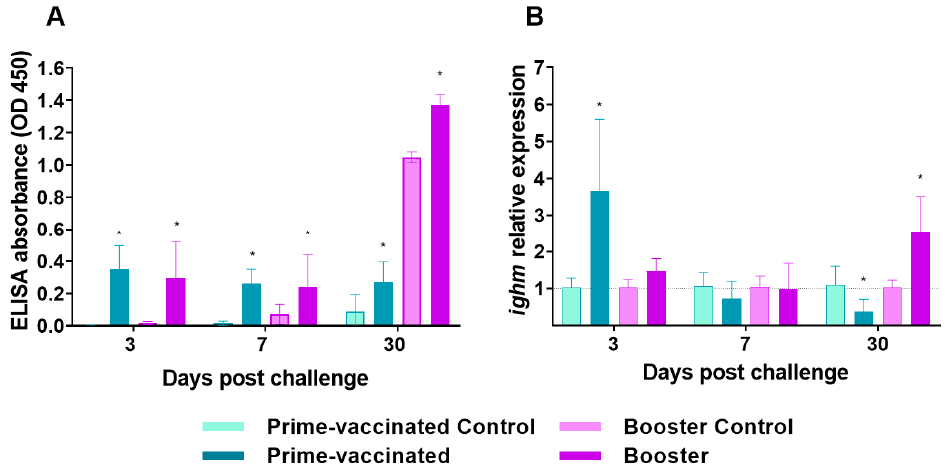
Figure 6. IgM levels in the serum ( A ) and transcription of igm ( B ) in the head-kidney of vaccinated and re-immunized fish at 3-, 7-, and 30-days post challenge (dpc). Challenge was performed by intramuscular injection with 2 × 10 3 TCID 50 /g for prime- and booster-vaccinated fish, respectively. Data represent the mean ± standard deviation (n = 6 fish/group and time). Asterisks represent statistical differences between control and prime-vaccinated/booster groups ( p < 0.05).